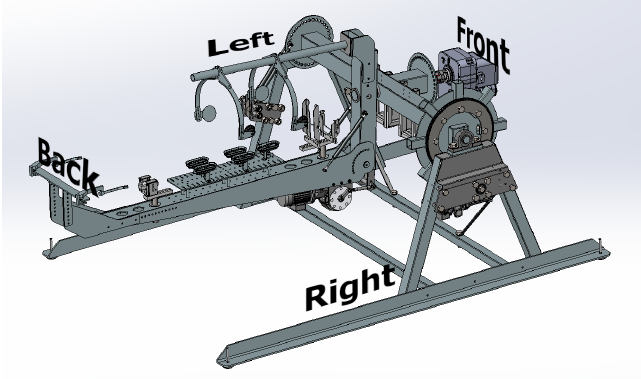
Figure 4. Carcass handling unit (CHU) with sides